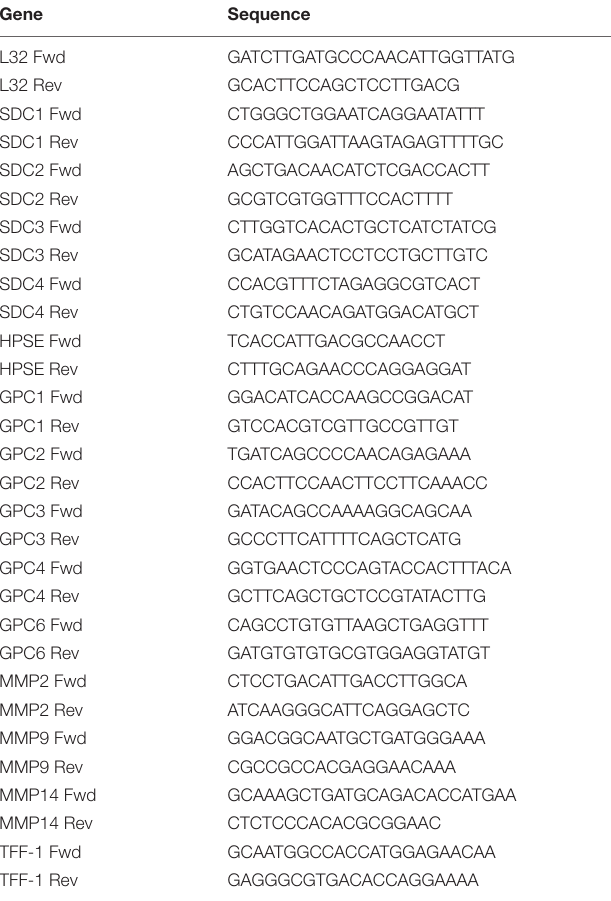
TABLE 2 | Sequences of RT-qPCR primers used in this study.